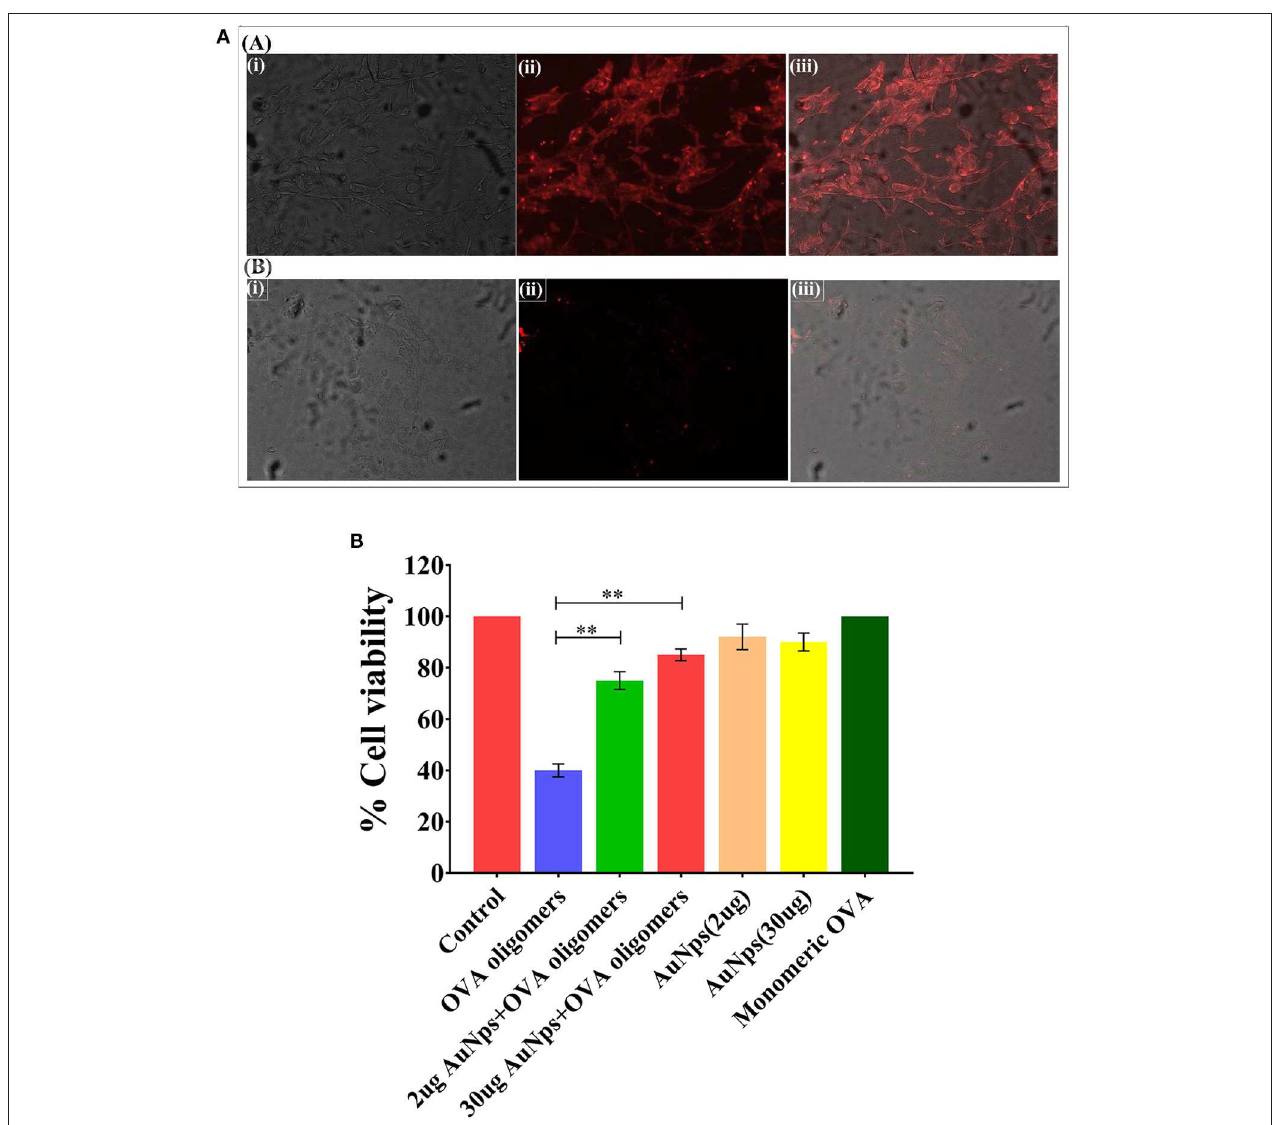
FIGURE 5 | (A) Uptake of B-AuNPs by neuroblastoma SH-SY5Y cells: The neuroblastoma cells were cultured on the glass cover slip overnight. The incubation of B-AuNPs with SH-SY5Y cells resulted in uptake of NPs in both time and concentration dependent manner. The epifluorescence micrographs of cultured neuroblastoma cells in absence [A] or presence [B] of B-AuNPs. (B) MTT Cell Viability Assay: MTT cell viability assay was performed to assess potential of as-synthesized B-AuNPs to inhibit toxic OVA fibril synthesis. OVA fibril impart toxicity to neuroblastoma SH-SY5H cells, however, presence of B-AuNPs slows down synthesis of oligomeric OVA species. The less amount of toxic OVA oligomers does not adversely affect neuroblastoma cells. Significance level have been denoted with the